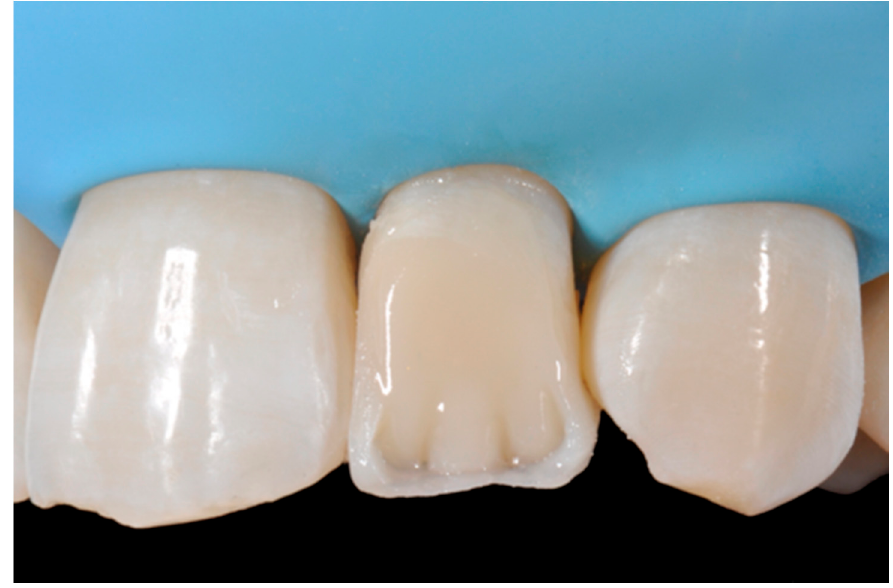
Figure 25. Internal dentinal anatomy. Reprinted from Restauri diretti nei settori anteriori, G. Paolone, S. Scolavino, © 2021, with permission from Quintessence Publishing Italy.